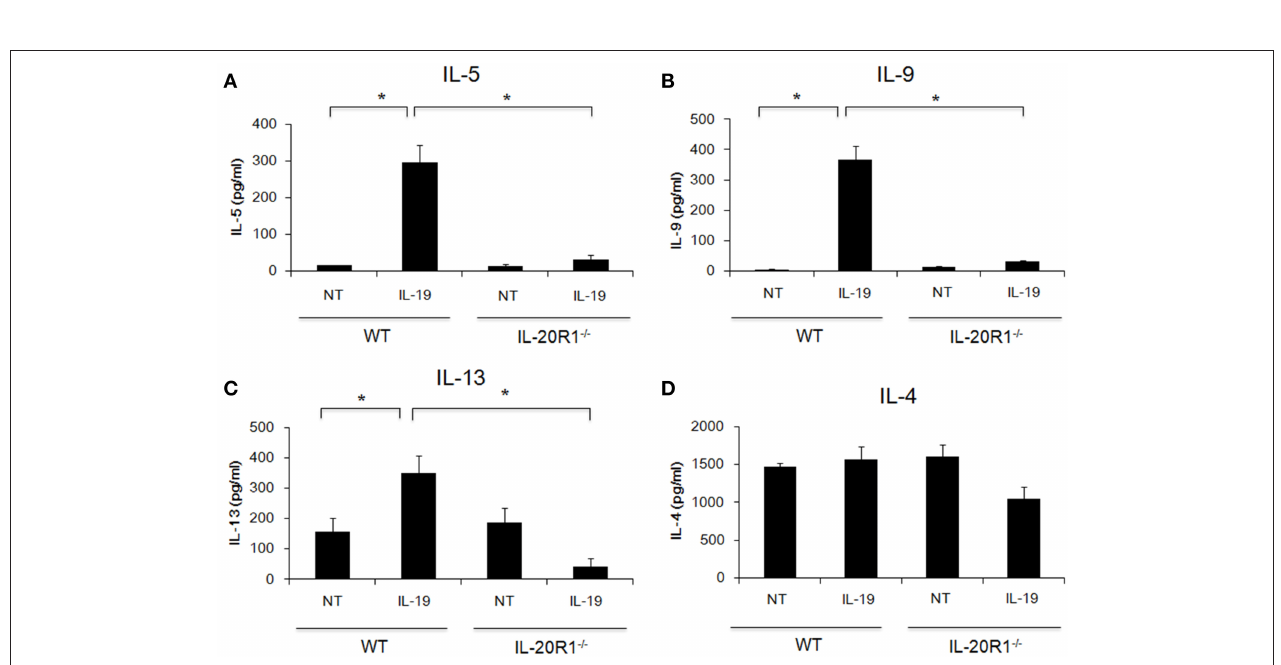
FIGURE 2 | Deficiency of IL-20R1 attenuated IL-19-induced Th2 cell polarization in vitro . A negative selection of CD4 + T cells were isolated from the spleens of wild-type C57BL/6 (WT) and IL-20R1 − / − mice and then incubated on a plate coated with anti-CD3 and anti-CD28 monoclonal antibodies (mAbs), and then the CD4 + T cells were incubated in Th2-differentiaion condition with PBS or IL-19 (200ng/ml) for another 7 days as described in the methods section. Conditioned medium was collected on day 7, and (A) IL-5, (B) IL-9, (C) IL-13, and (D) IL-4 expression levels were analyzed using ELISA. The expression of T-helper 2 (Th2) cytokines on IL-19-treated CD4 + T cells was upregulated. Data are the average of duplicate samples. NT, not treated (PBS controls). * P < 0.05 by one-way non-parametric ANOVA.